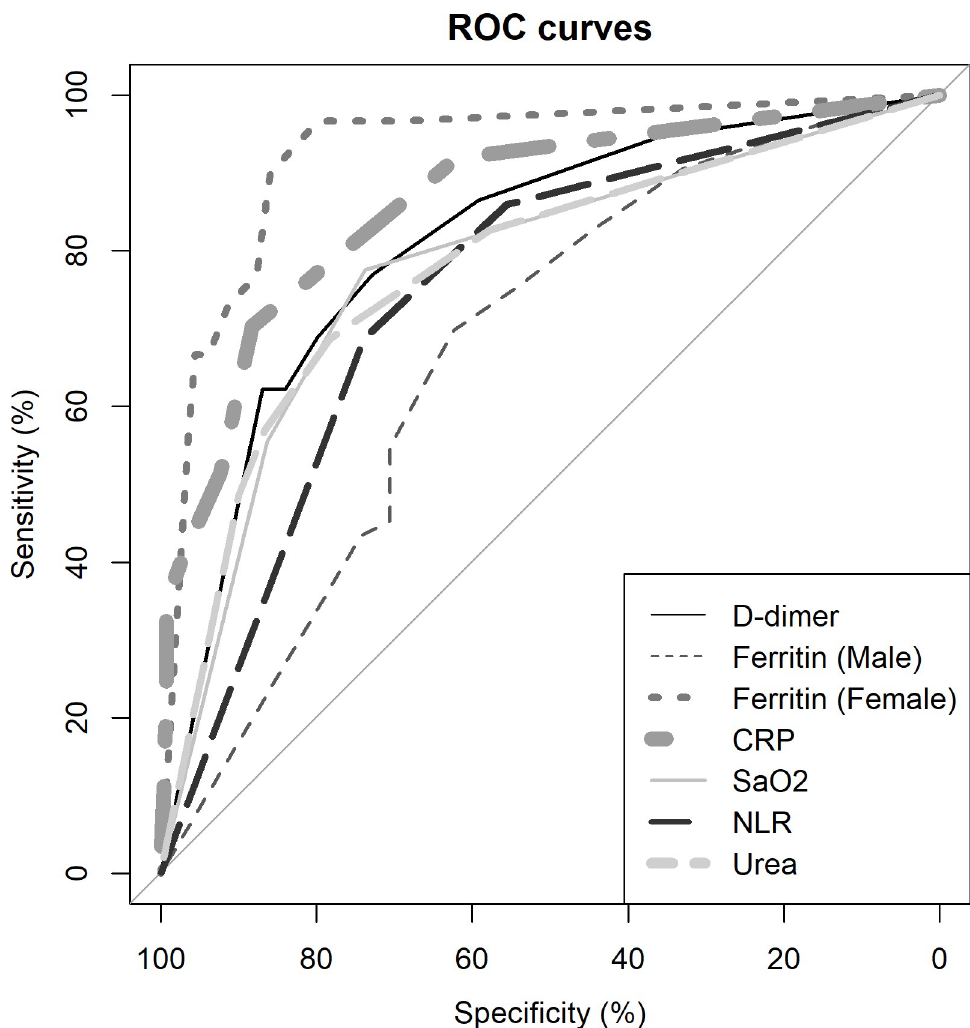
in predicting mortality. Definition of Abbreviations: ROC Curve—Receiver Operating Characteristic Curve, CRP- C-Reactive Protein, SaO 2 —Peripheral Oxygen Saturation, NLR—Neutrophil-to-Lymphocyte